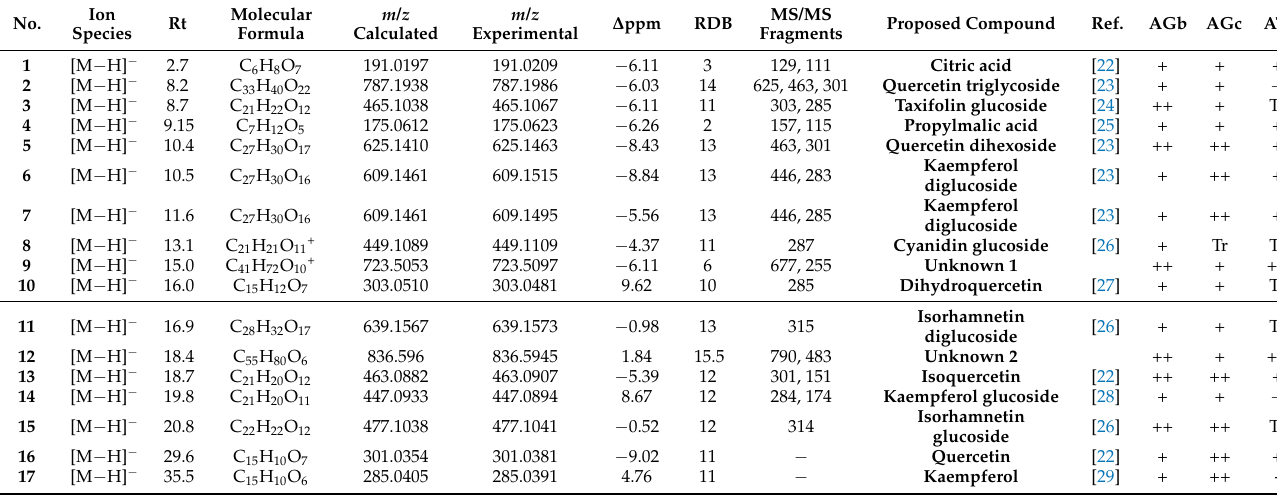
Table 1. The list of detected metabolites in the 50% ethanol extracts from different organs of Kazakhstani onions— Allium galanthum and Allium turkestanicum (AGb, AGb, ATb).